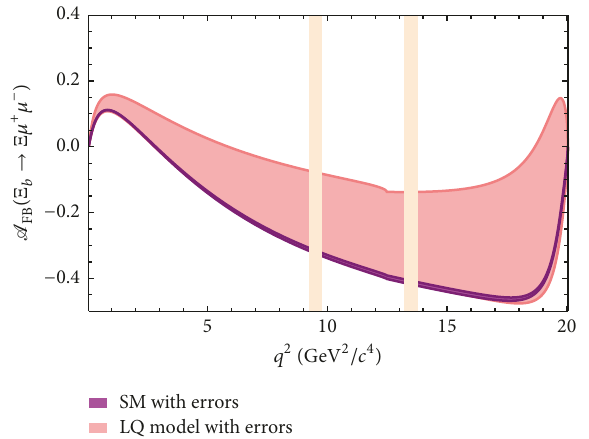
transition in the SM and LQ models. The vertical shaded band indicates the charmonia veto region.